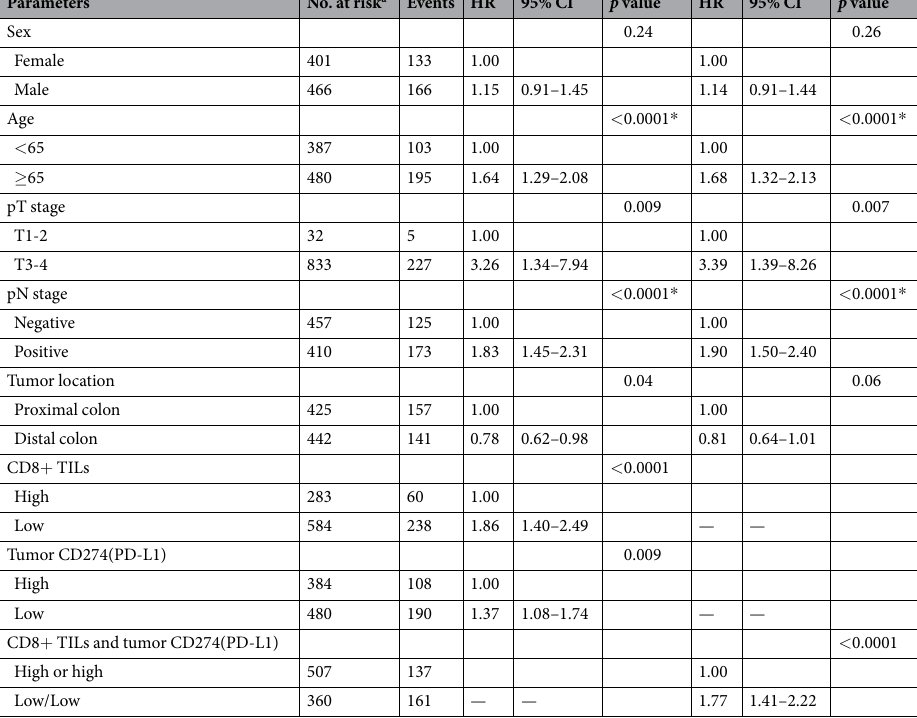
Table 5. Multivariate analysis of DFS and known prognostic factors in stage II-III colon carcinoma patients. a Number of cases may differ due to missing data. * p < 0.005 is significant and 0.005 < p < 0.05 is suggestive